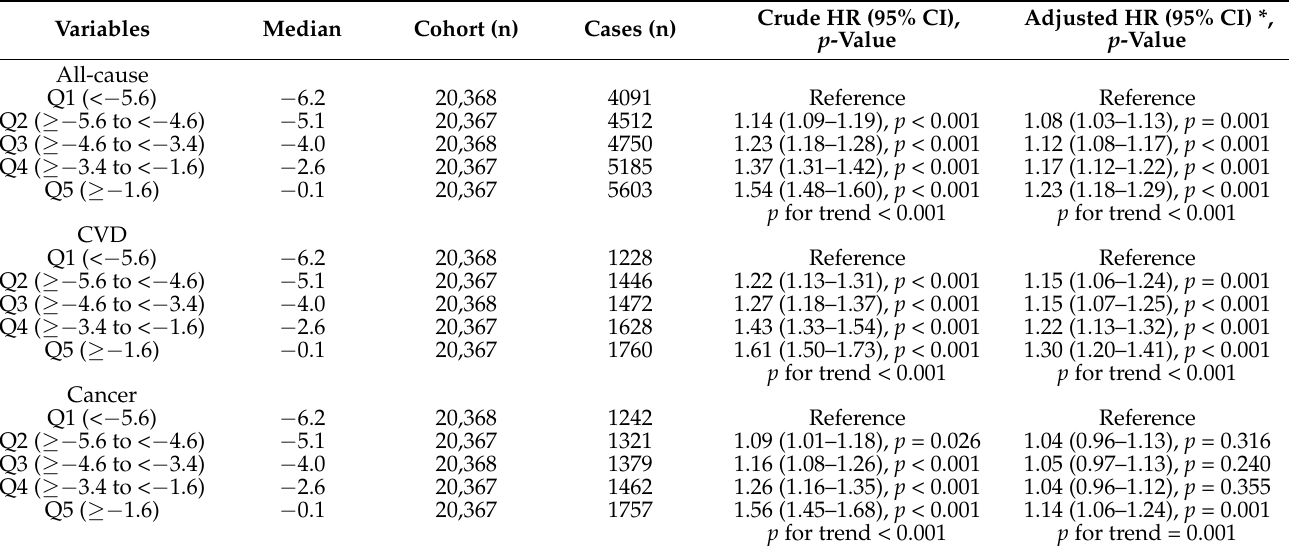
Table 2. Associations of total mortality, CVD mortality, or cancer mortality with E-DII from the Prostate, Lung, Colorectal and Ovarian (PLCO) Screening Trial, 1993 to